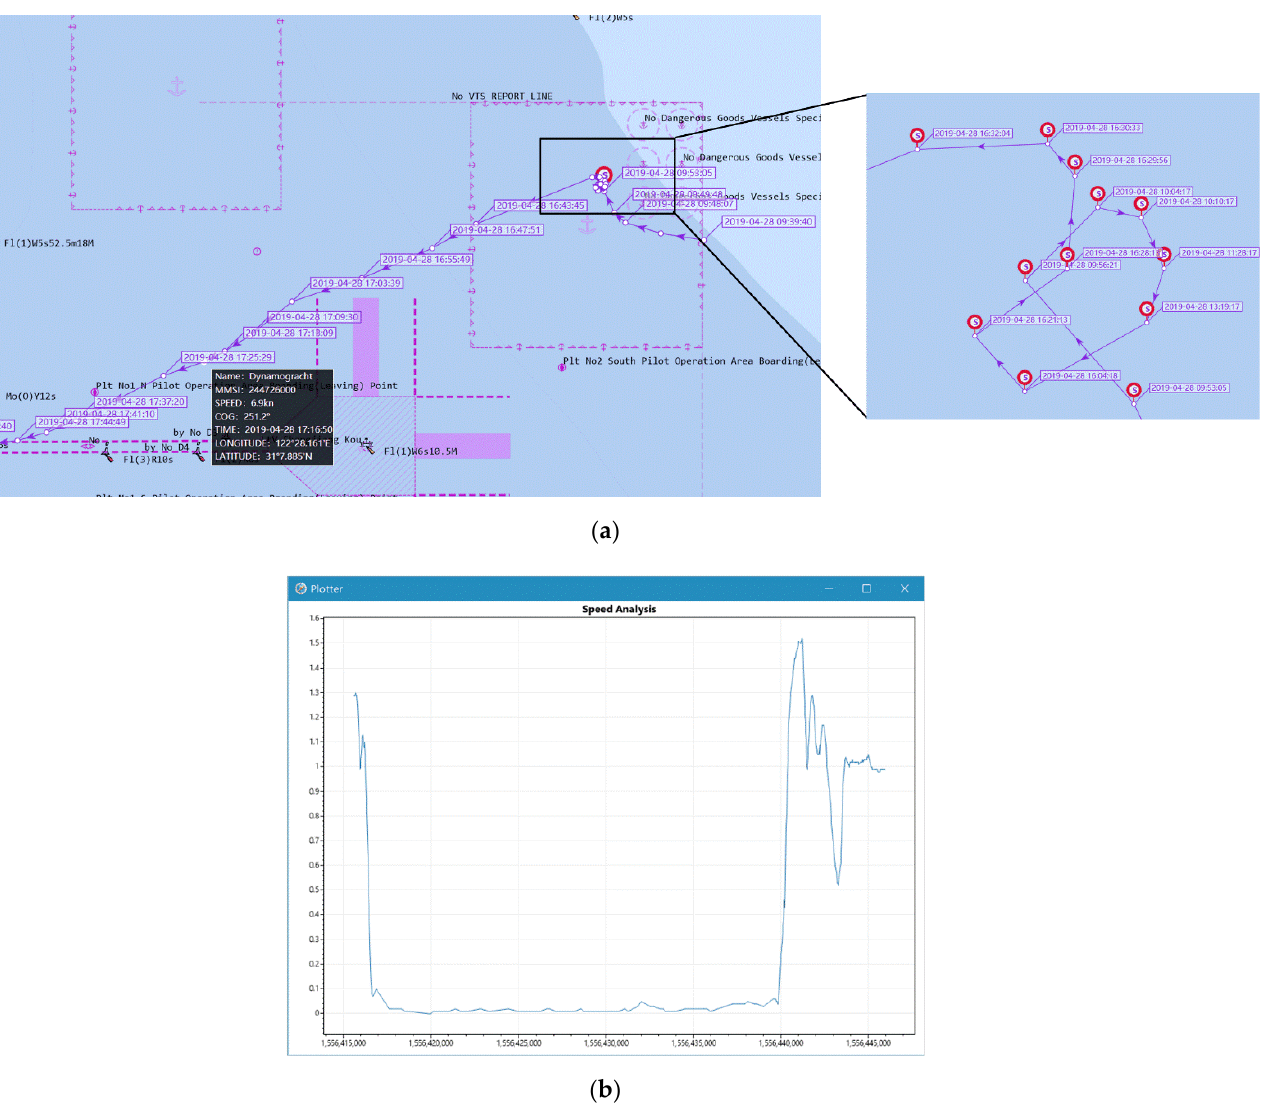
Figure 6. Single-vessel trajectory display: ( a ) the trajectory display of a single vessel; ( b ) speed analysis.